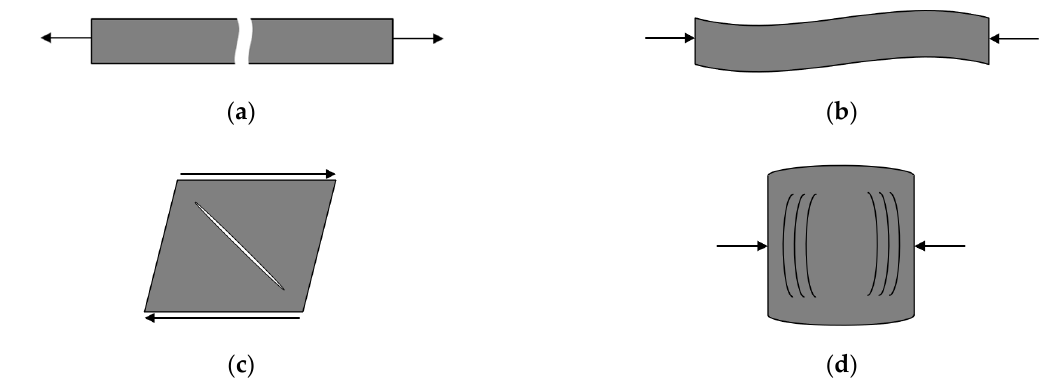
Figure 4. The Hashin composite-failure modes represented by their own normalized failure variable ( f i ): ( a ) fiber tension mode, ( b ) fiber compression mode, ( c ) matrix tension/shear mode, ( d ) matrix compression mode. Table 3. Degradation scheme for progressive composite damage [18].